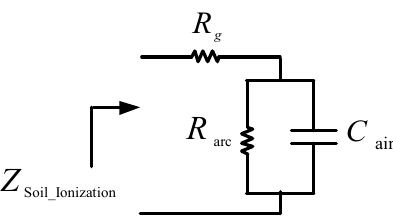
Figure 5. Complete model of soil ionization behavior.